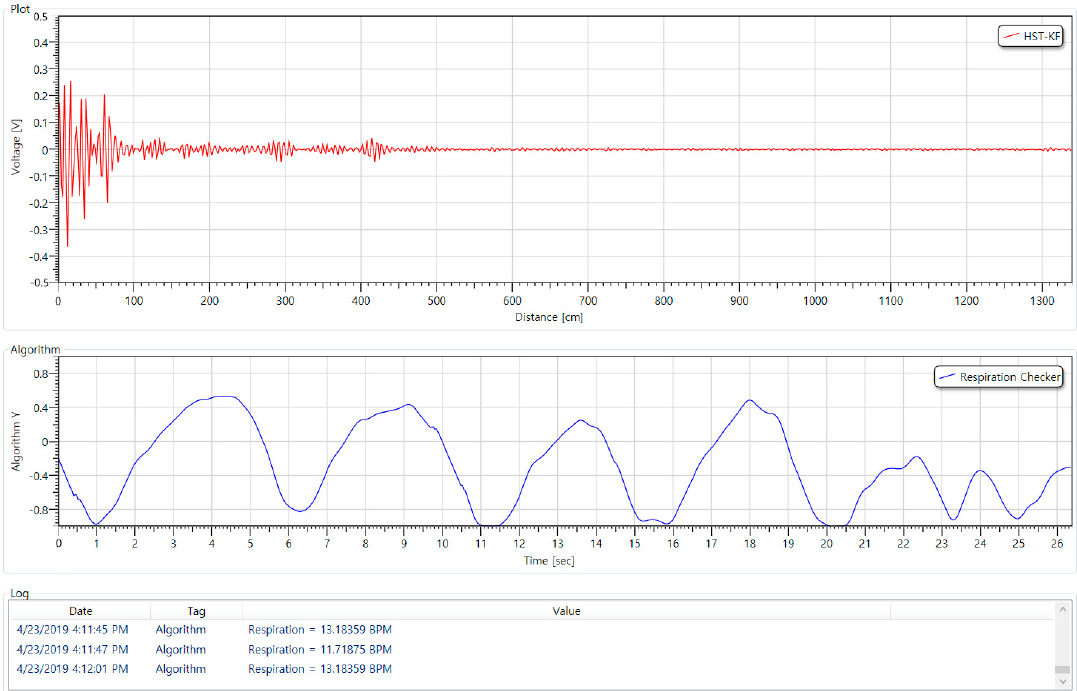
Figure 10. UWB Radar PC program for extracting respiratory signal data.